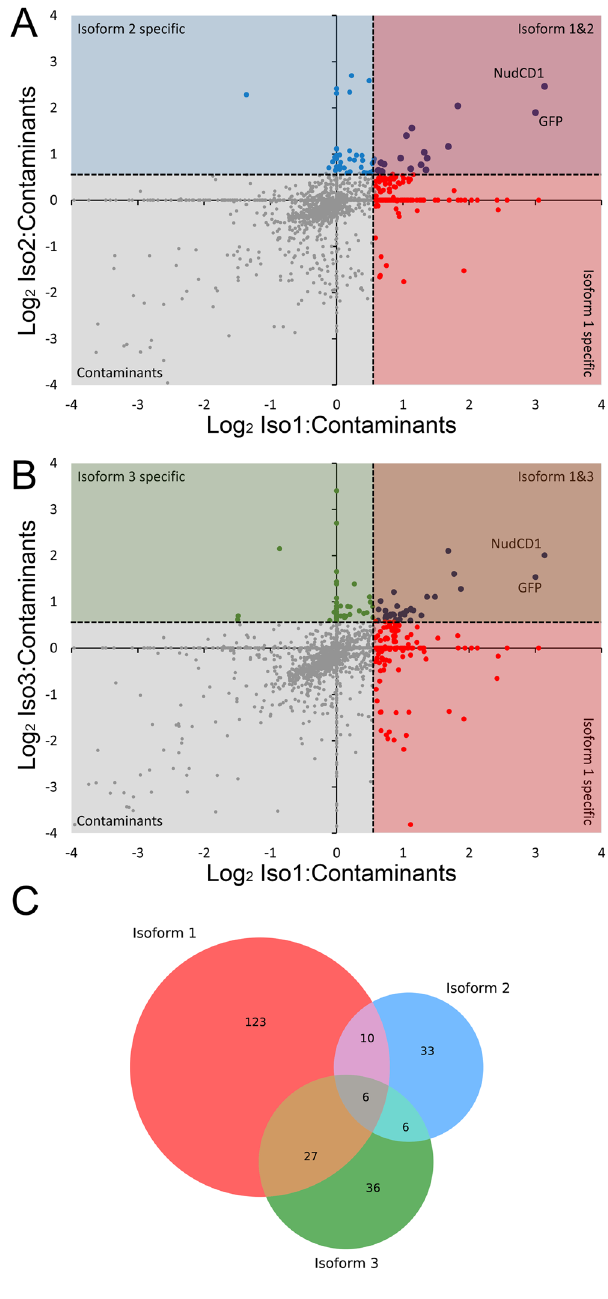
Figure 3. Identification of NudCD1 isoform-specific interacting partners. NudCD1 interacting partners were identified using a combination of immunoprecipitation following by quantitative mass spectrometry analysis using triple-labeling SILAC. Cells not expressing NudCD1 were grown in “light” (L) media, cells expressing NudCD1 isoform 1 were grown in “medium” (M) media and cells expressing either NudCD1 isoform 2 or isoform 3 were grown in cells grown in “heavy” (H) media. Immunoprecipitation were performed using the recombinant GFP-Trap_A reagent by combining a control, isoform 1 and isoform 2 ( A ), or a control, isoform 1 and isoform 3 ( B ). The overlap between the proteins identified as interactors for each isoforms is displayed as a Venn diagram ( C